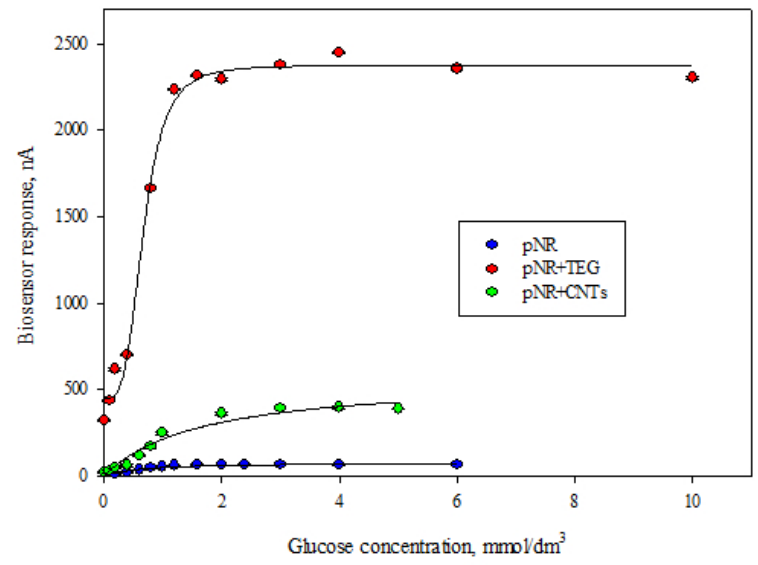
Figure 7. Calibration dependences of biosensors based on pNR and its nanocomposites.